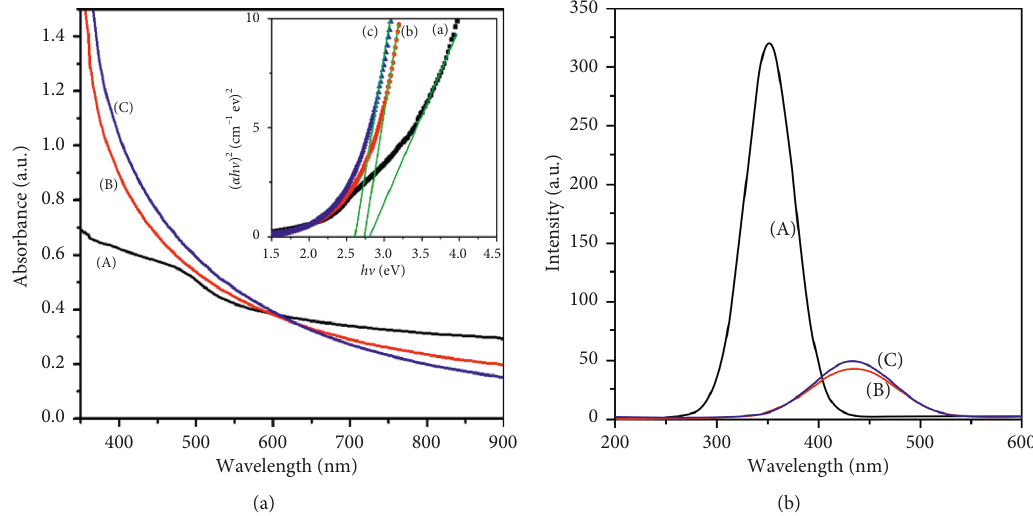
Figure 3: UV-Vis absorption spectra and their Tauc plots (inset) (a) and photoluminescence (PL) (b) of (A) CdS, (B) TiO TiO 2 hybrid nanoparticles,